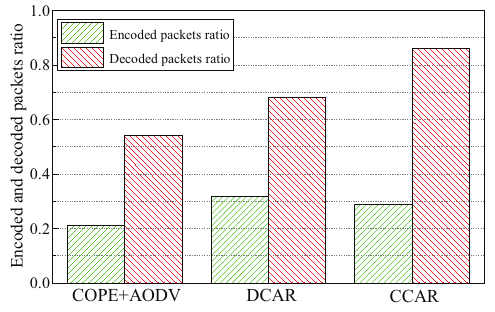
Figure 9. Encoded and decoded packet ratios.